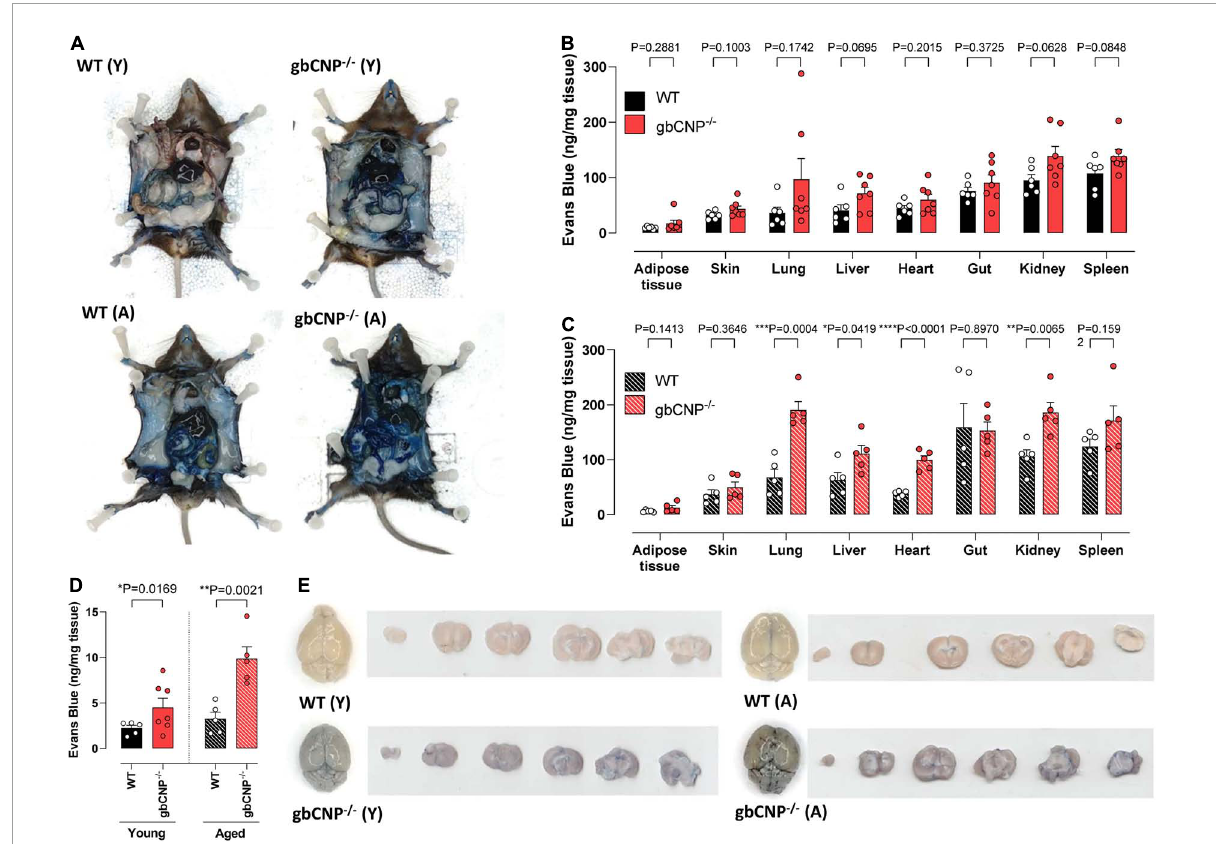
FIGURE6 Young adult and aged gbCNP - / - mice had increased blood brain barrier extravasation. Representative images of wild-type (WT) and global CNP knockout (gbCNP - / - ) mice at 45 min following Evans blue intravenous administration (A) . Evans blue extravasation in the organs of young adult ( 12 weeks, Y; B) and aged ( 65 weeks, A , C) mice, and in the brain of WT and gbCNP - / - animals (D) . Representative images of Evans blue extravasation in whole brains and brain sections from young adult (12 weeks, Y) and aged (65 weeks, A) mice (E) . n = 5-7. Statistical analysis by two-tailed Student’s t-test. Each statistical comparison undertaken has an assigned P value (adjusted for